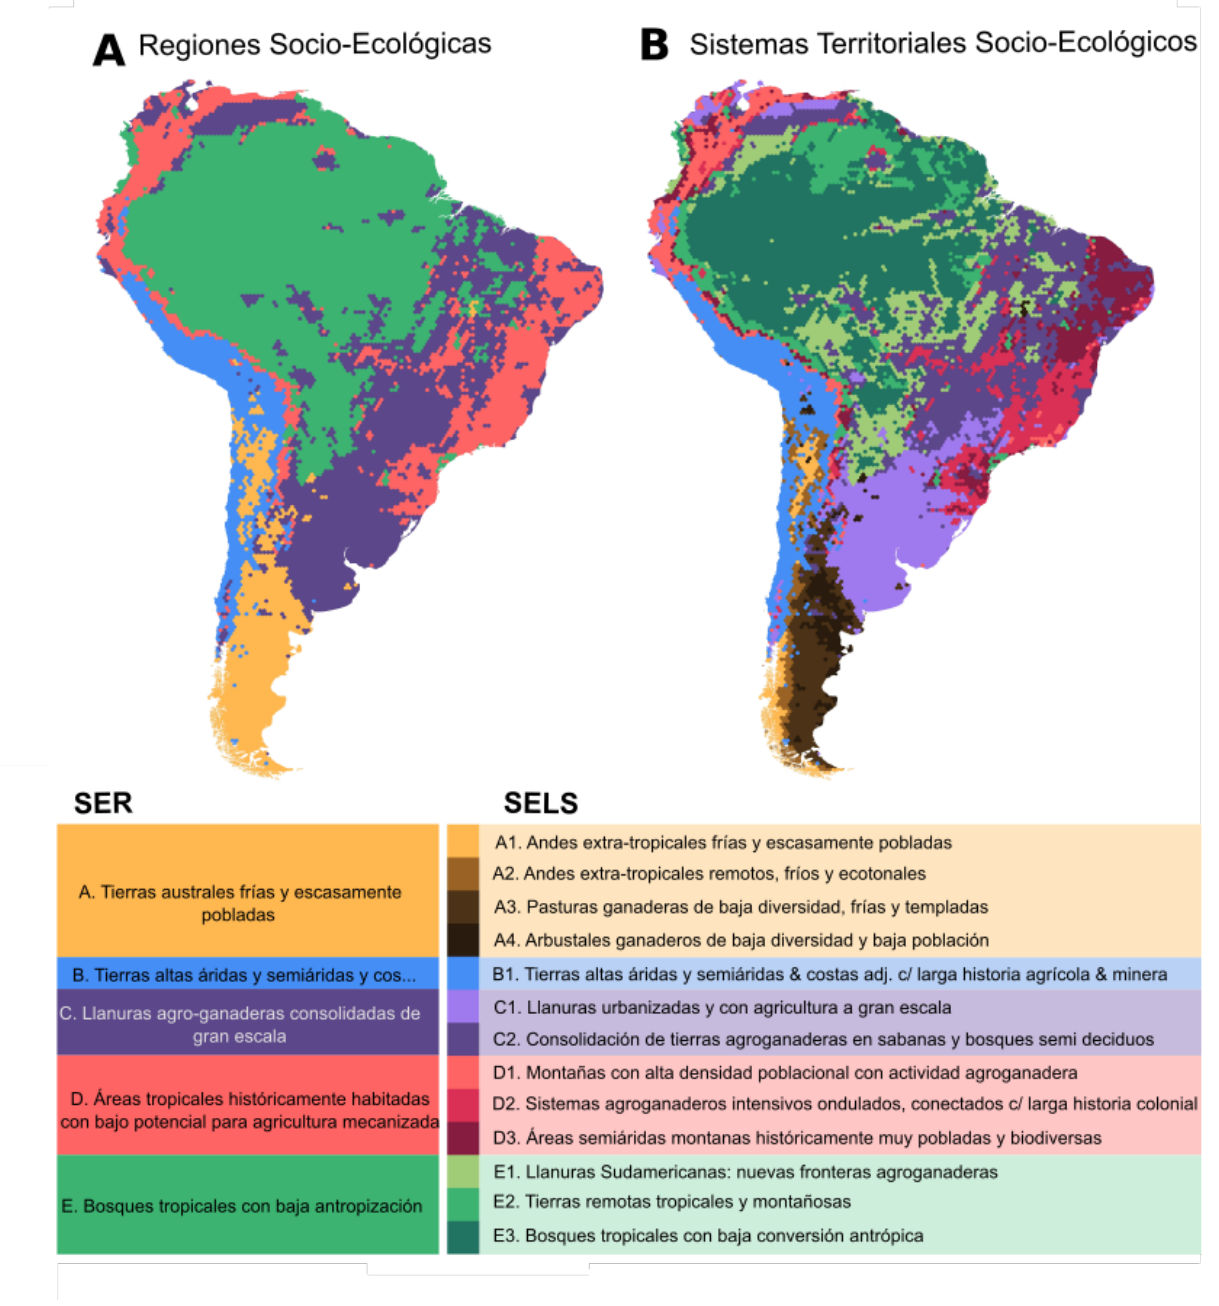
Figure 1. Mapa de las Regiones Socio-Ecológicas (A) y Sistemas Territoriales Socio-Ecológicos (B) de Sudamérica. El mapa representa la distribución espacial de las clases descriptas en la sección 3.2. En el material suplementario encontrarán una versión del mapa en alta